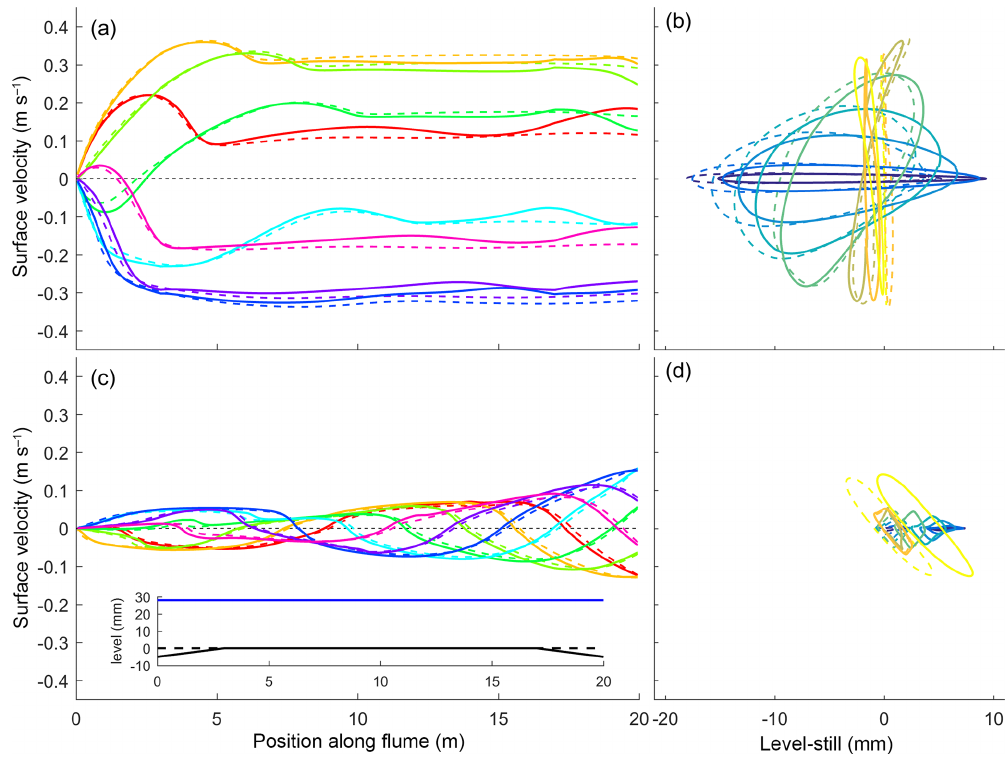
Figure 14. Sensitivity of flow to depth variation in the basin (drawn lines) compared with the ideal depth (dashed lines) for 30s period model runs. Inset in panel (c) shows modified bed elevation. Runs with original depth are the same as in Fig. 9. (a, c) Flow velocity at the water surface along the flume for selected phases of the tidal cycle. Legend as in Fig. 9. (b, d) Water level and flow velocity in one tidal cycle showing hysteresis. (a, b) Tilting at 0.09m of amplitude with upstream boundary closed. (c, d) Reynolds method with sea level fluctuation at 0.01m of amplitude with the landward boundary